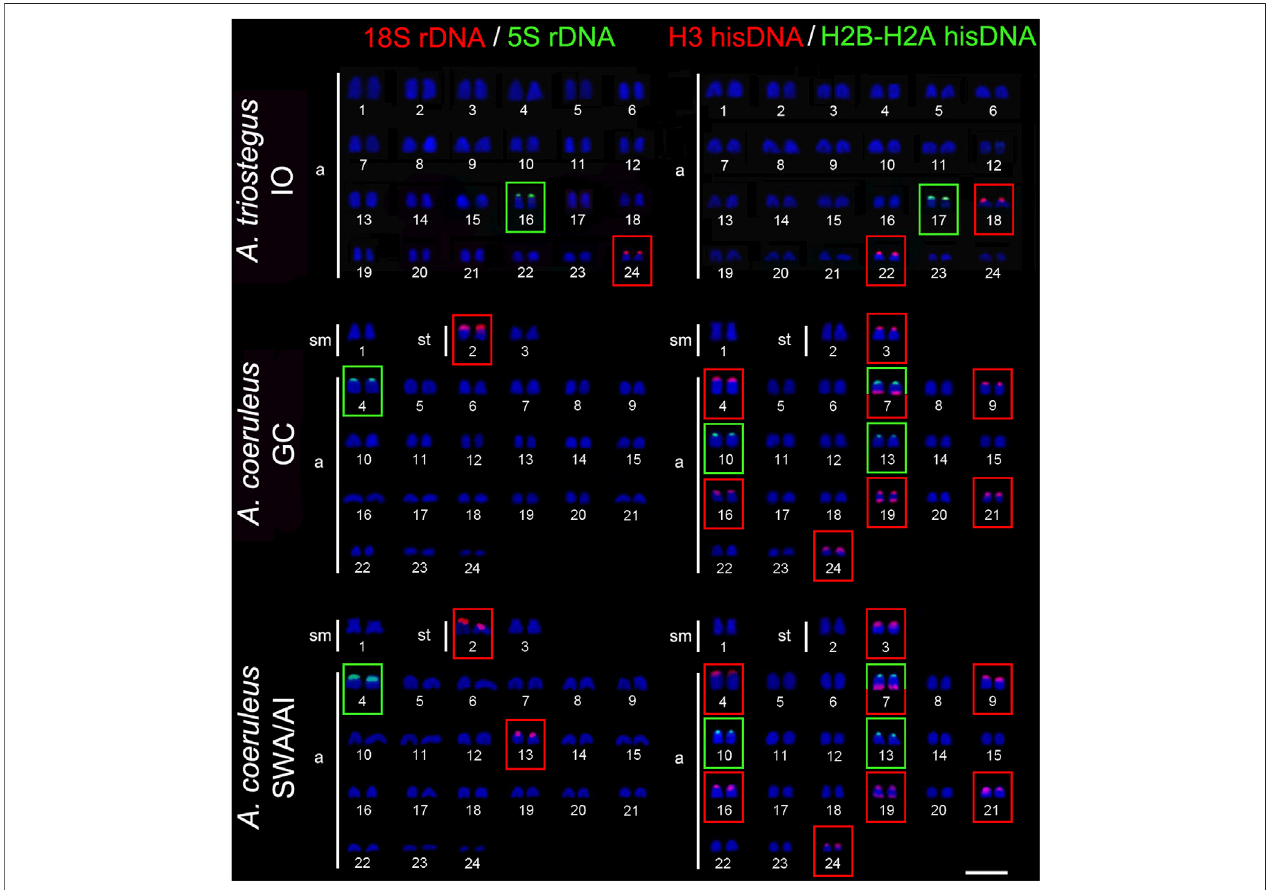
FIGURE2| Fluorescence insitu hybridization signalsindicatingthedistributionofthe18SrDNA(redsignals),5SrDNA(greensignals),H3hisDNA(redsignals)and H2B-H2A hisDNA (green signals) sites in chromosomes of Acanthurus triostegus and Acanthurus coeruleus . Scale bar (cid:2) 5 μ m. IO, Indian Ocean; SWA, Southwest Atlantic; AI, South Atlantic Islands; GC, Greater